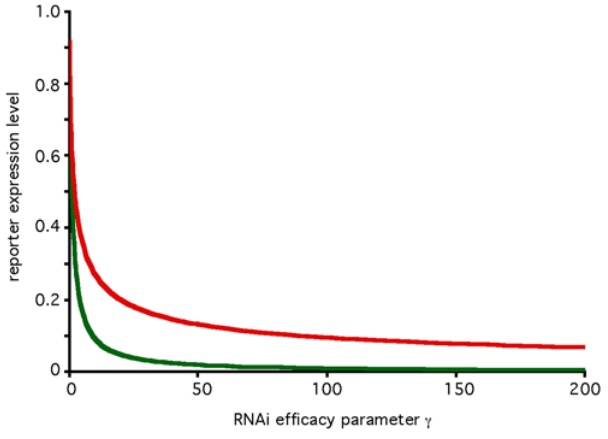
Figure 3. Restoration of reporter expression during recursive RNAi. Predicted reporter expression in the presence (red curve) and absence (green curve) of Dicer-specific RNAi. As the two curves approach each other, the restoration becomes more difficult to